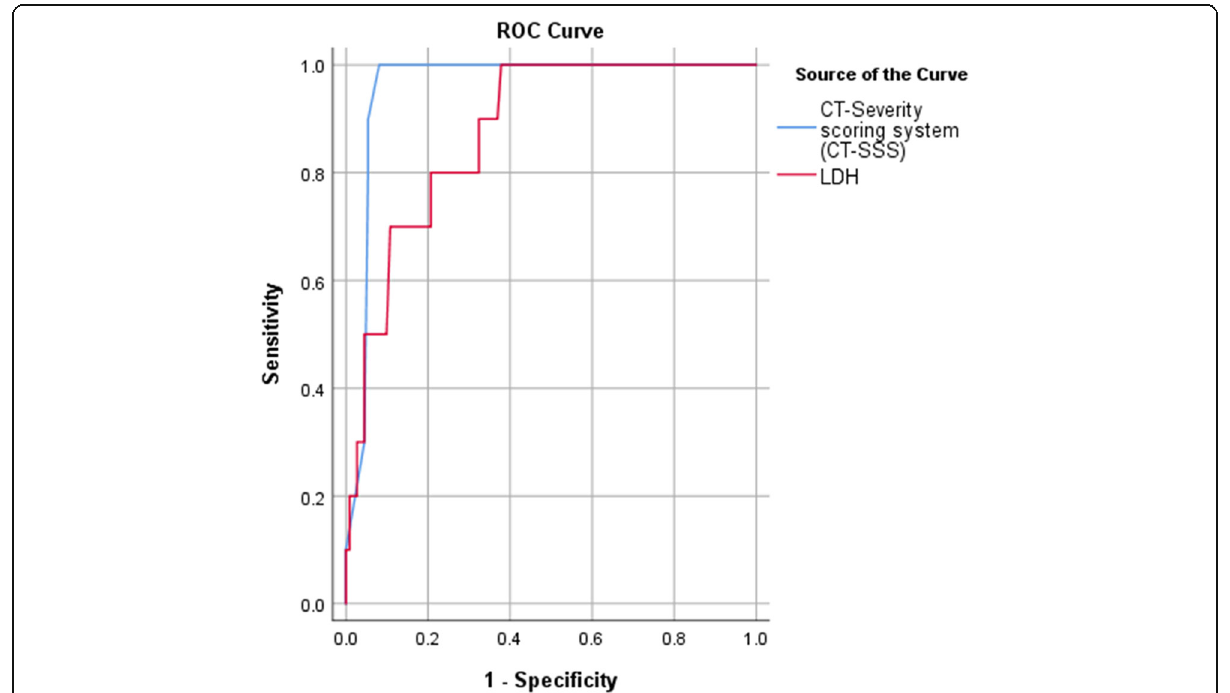
Fig. 8 ROC curve for COVID-19 mortality using CT-SSS and